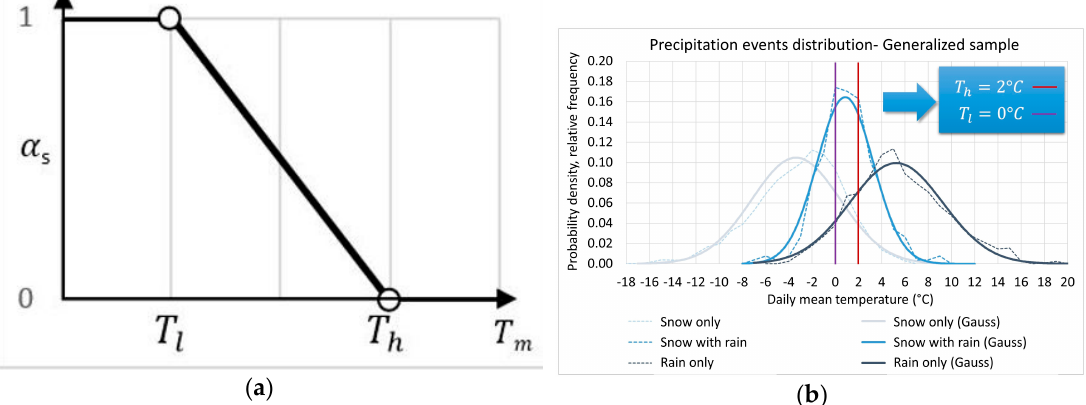
Figure 6. ( a ) Variability of the coefficient α s as a function of mean daily temperature. ( b ) Probability density distribution of the precipitation events as a function of the daily mean temperature for the generalized sample, obtained joining many single station samples (S. Caterina Valfurva, Livigno